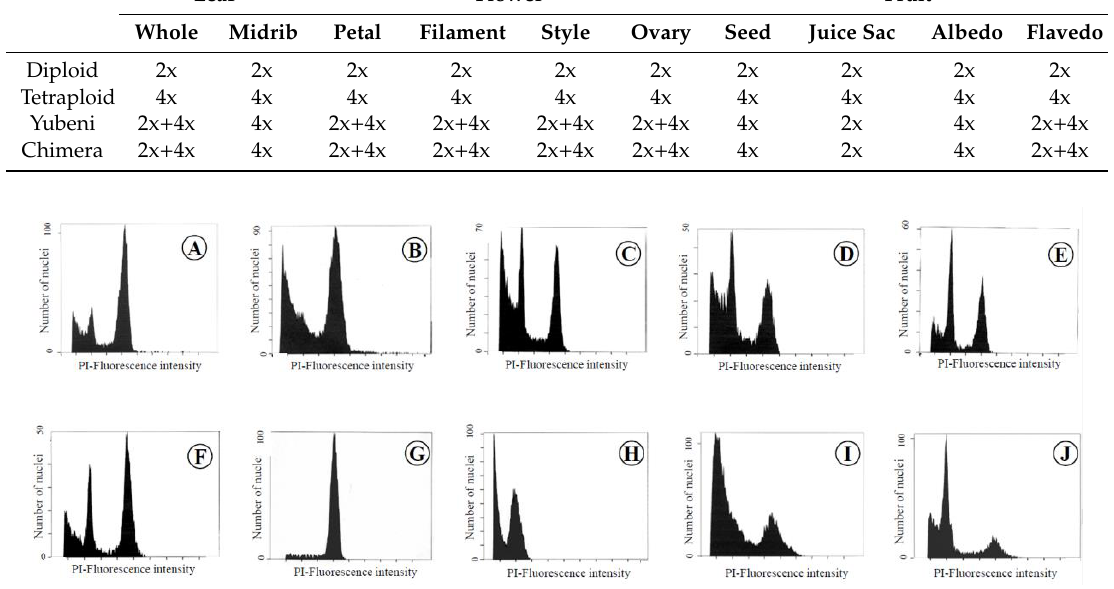
Table 2. Comparison of morphological characteristics of leaves in the diploid, the tetraploid, the Yubeni, and the chimera of the Meiwa kumquat.